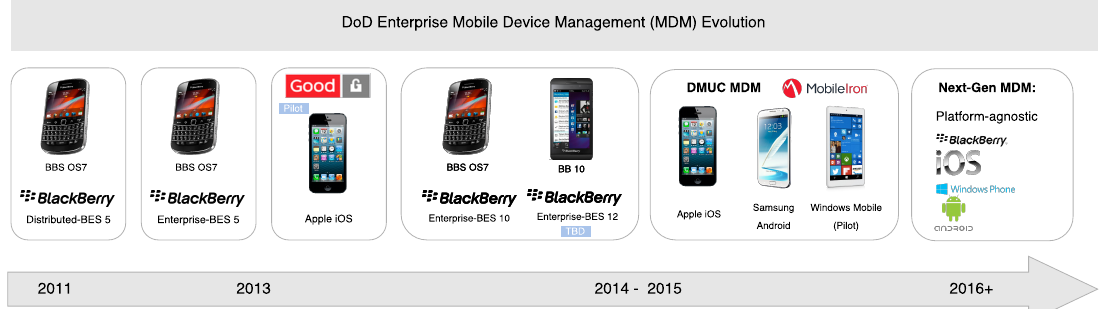
Figure 7. DoD Enterprise Mobile Devices Management (MDM)